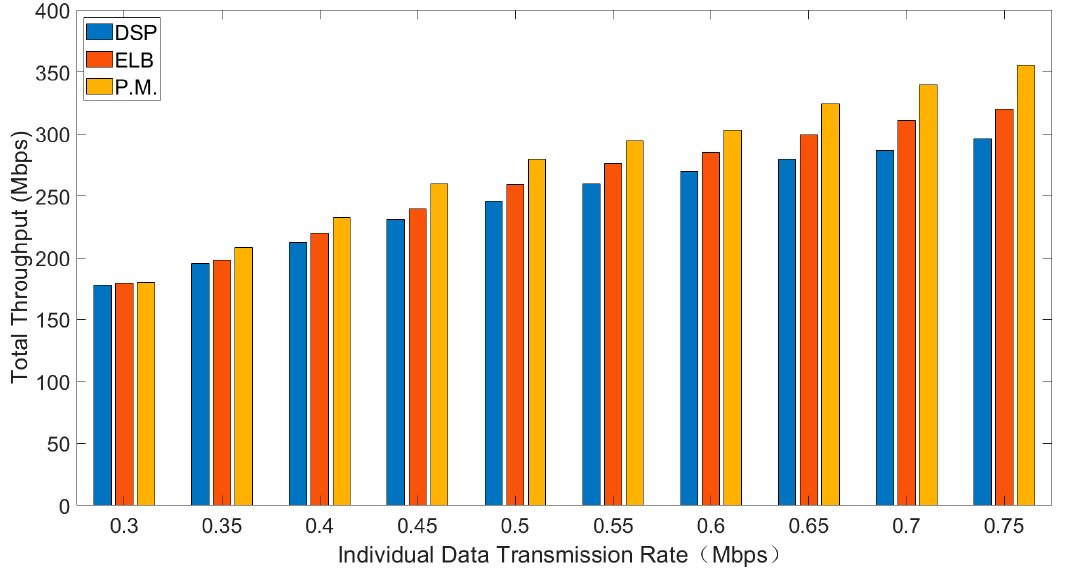
Figure 5. The total throughput for different sending rates.